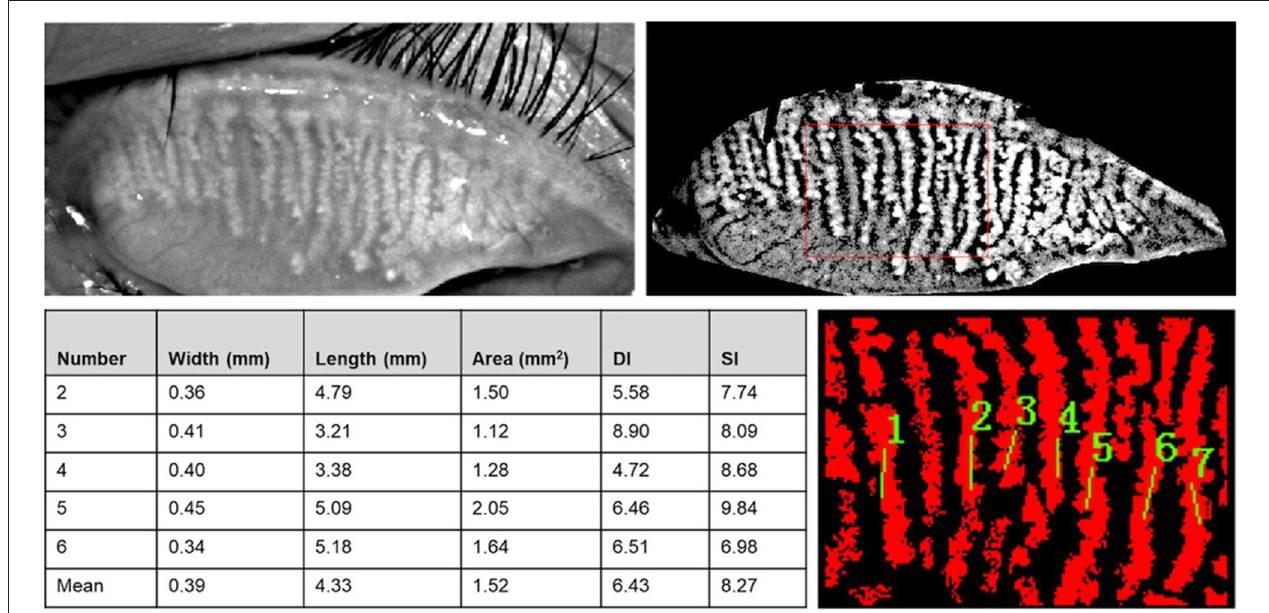
FIGURE 3 | Meibomian Gland Bio-image Analyzer V3 software dealt with images from K5M and dampened the random noises and highlighted the visibility of glands. The width, length, area, DI, and SI of central five MGs were obtained after choosing the central part of the image and marked the MGs.